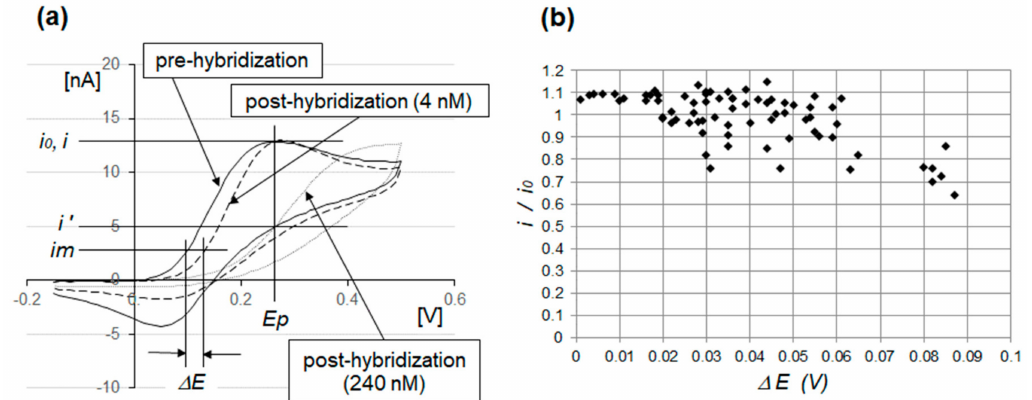
Figure 4. ( a ) Cyclic voltammograms (CVs) of gold electrodes modified with a PNA probe (N3) and 6-hydroxy-1-hexanthiol (6-HHT). The solid line indicates the prehybridization curve, while the dotted lines indicate the posthybridization curves at 240 nM and 4 nM of miRNA (R3). At 4 nM, the sensitivity of i / i 0 was poor, while the sensitivity of ∆ E was high. ( b ) A 74-pc correlation chart for i / i 0 and ∆ E is shown, representing when the complementary target miRNA (R3) concentration was 4 nM. Compared to the conventional i / i 0 evaluation parameter, ∆ E has higher sensitivity and is more suitable for detecting low miRNA